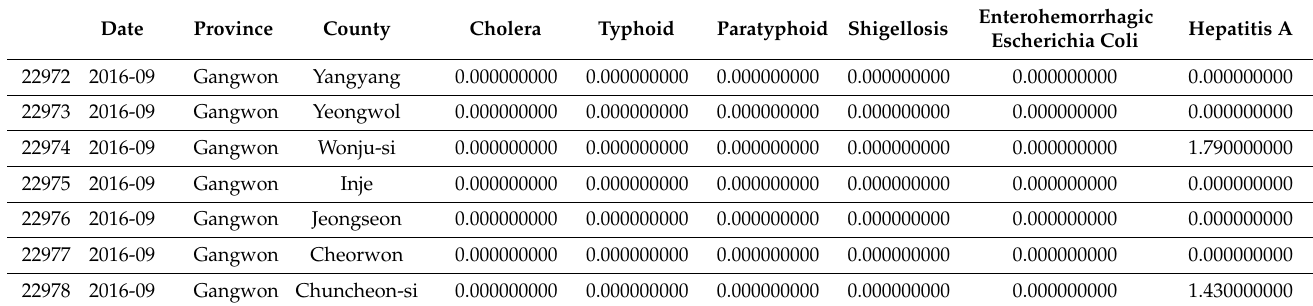
Table 2. Examples of web crawling data.